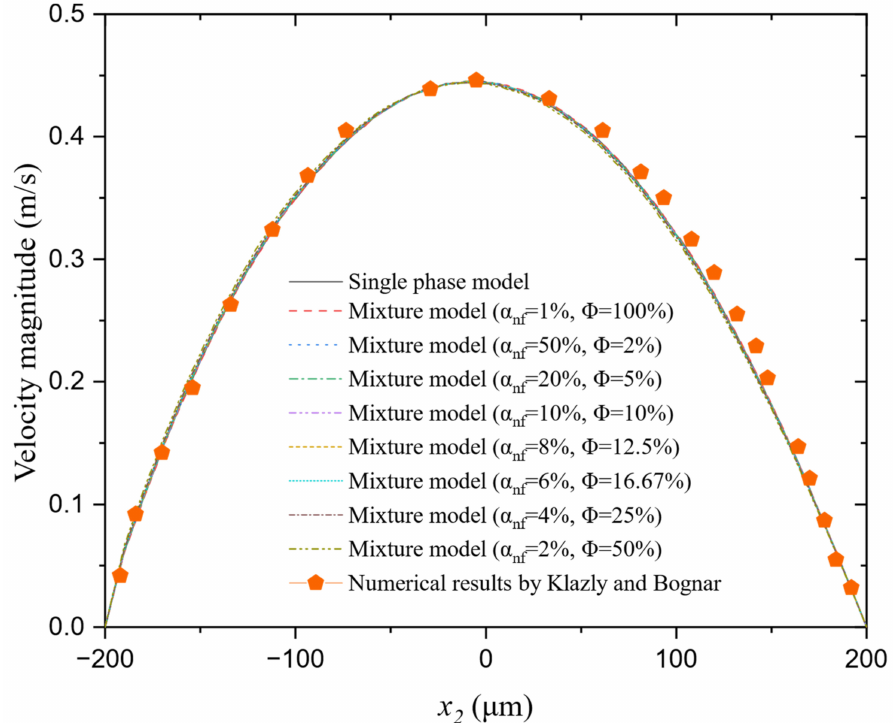
Figure 15. Velocity profile above the backwards-facing step, at the location of the channel sudden